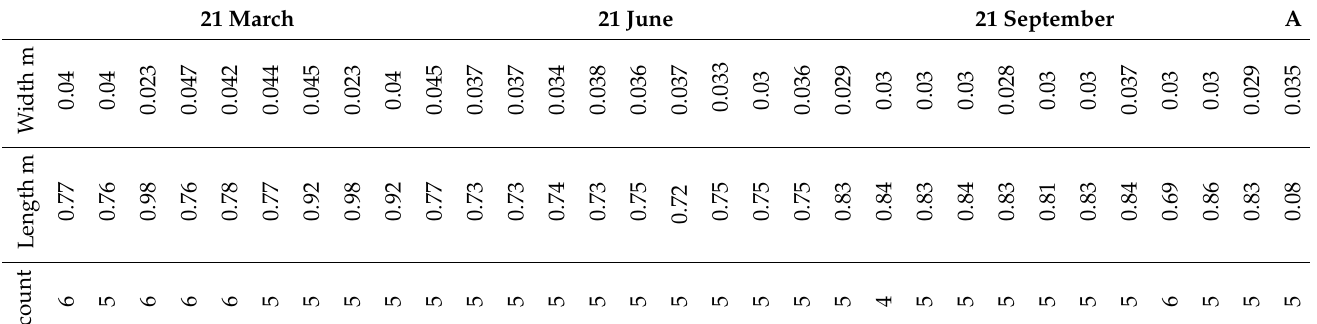
Table 2. Optimization process of the fin’s parameters in March, June, and September.